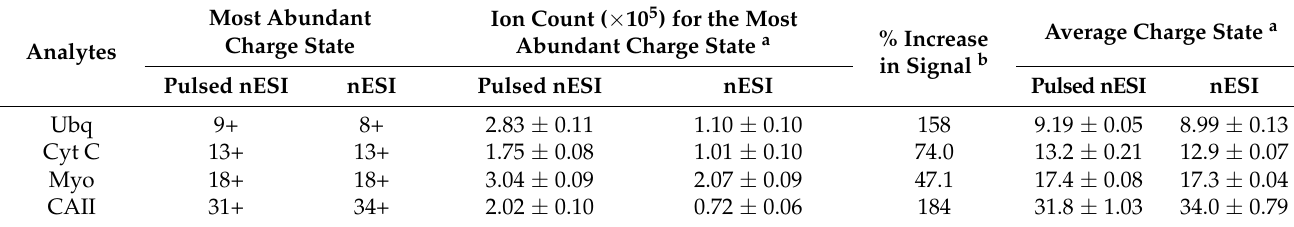
a Values correspond to the mean ± standard deviation of at least three replicate measurements; b p -value < 0.05.